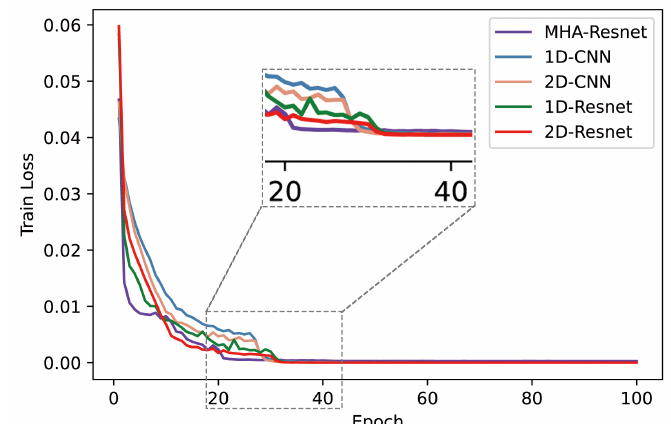
Figure 11. Training